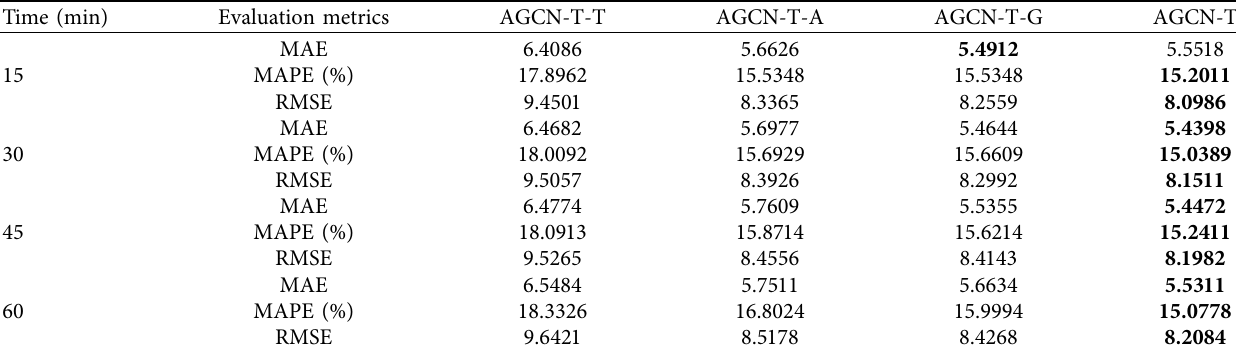
Table 8: Performance of variants of AGCN-T on